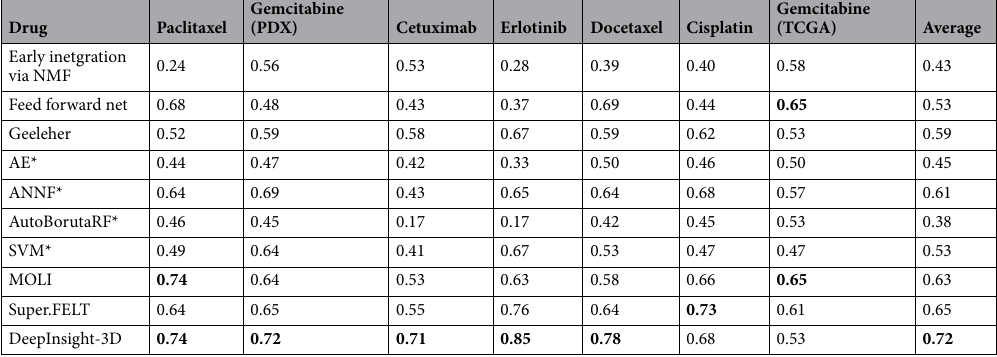
Pathway‑centric context of discovered gene sets.